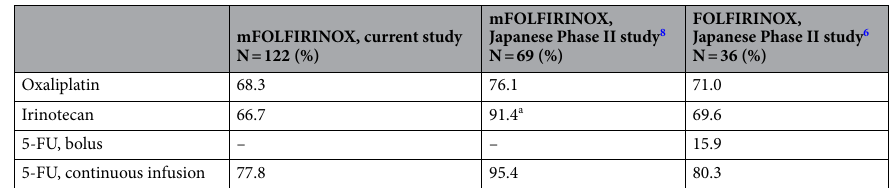
Table 3. Relative dose intensity. a Relative dose intensity of irinotecan, 150 mg/m 2